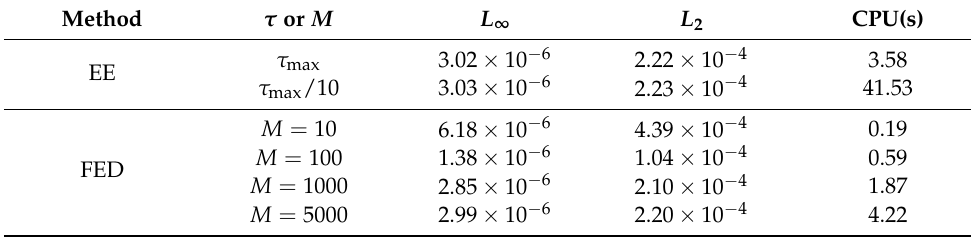
Table A1. Evaluation of the accuracy of the suggested methods at t F = 1 on the artificial setup from (A26). The analytical solution (A27) is evaluated with κ = 1 and the summation over n and m is truncated at n = m = 10. The grid size is fixed at h = 0.01. The stopping criterion of the CG method is based on the Euclidean norm of the relative residual with ε = 10 − 4 . Moreover, KSMOR is performed for and σ = 0, whereby q = 4 is sufficient to achieve the same results than the direct CN method. K 4 Method τ or